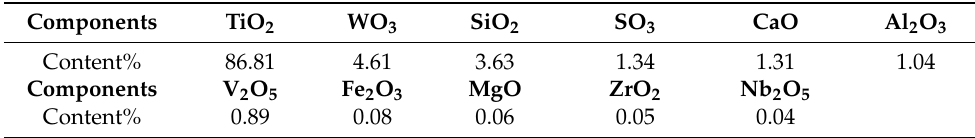
Table 2. XRF test results of the catalyst (wt.%).